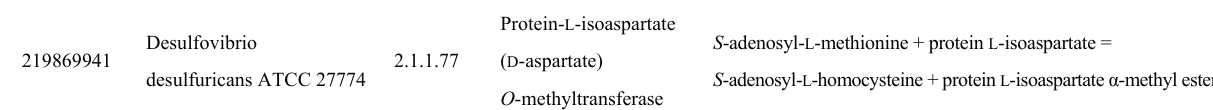
Table 10. SAM ( S -adenosyl-methionine) conversion to SAH ( S